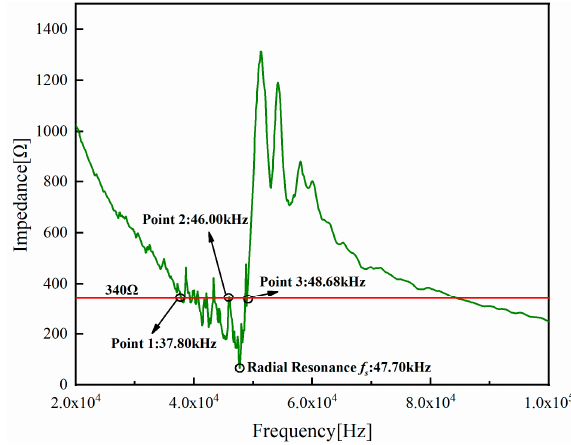
Figure 11. Impedance curve of PZT-4 bonded to a plate-coating-ice-layered structure.